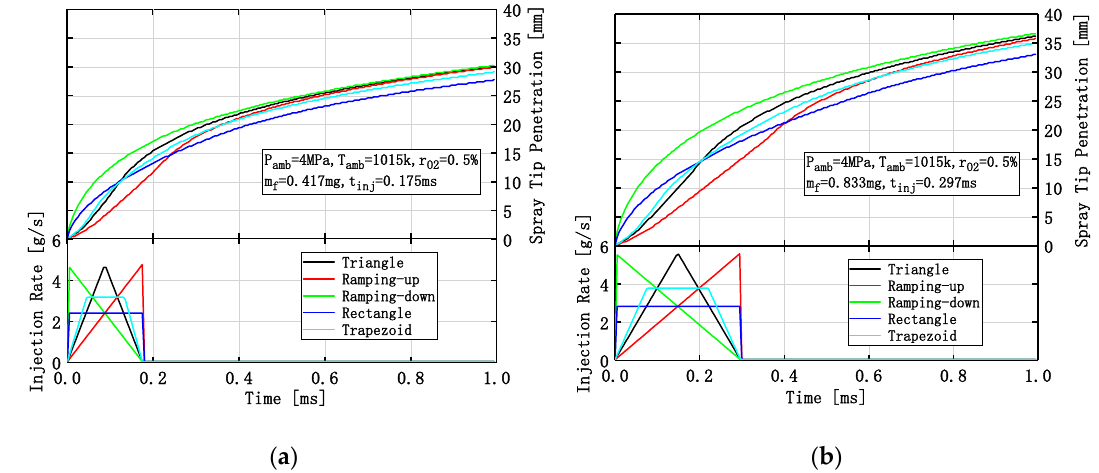
Figure 5. Spray tip penetration under ( a ) the injection quantity of 0.417 mg and ( b ) injection quantity of 0.833 mg NOTE. P amb : ambient pressure; T amb : ambient temperature; r O2 : volume fraction of O 2 in the ambient gas; m f : injection quantity of fuel for single nozzle hole; t inj : injection duration.